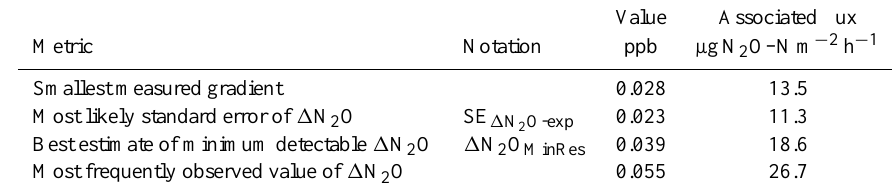
Table 3. Metrics describing the performance of the FS-NOMAS at measuring 1 N 2 O, F N significant at P < 0.05. SE 1 N calculated from peak value of all SE 1 N 2 O-exp interval of SE 1 N . The associated flux was calculated at the most likely value of the transfer coefficient C Tr , which was 4.8mol Air m − 2 s − 1 2 O